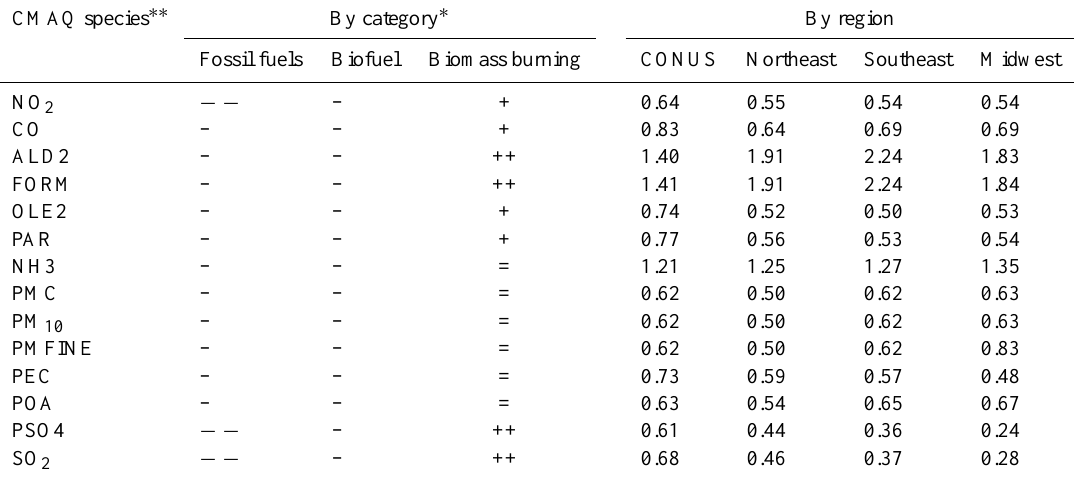
Table 2. The annual projection rates of anthropogenic emissions from present to future. CMAQ species ∗∗ By category